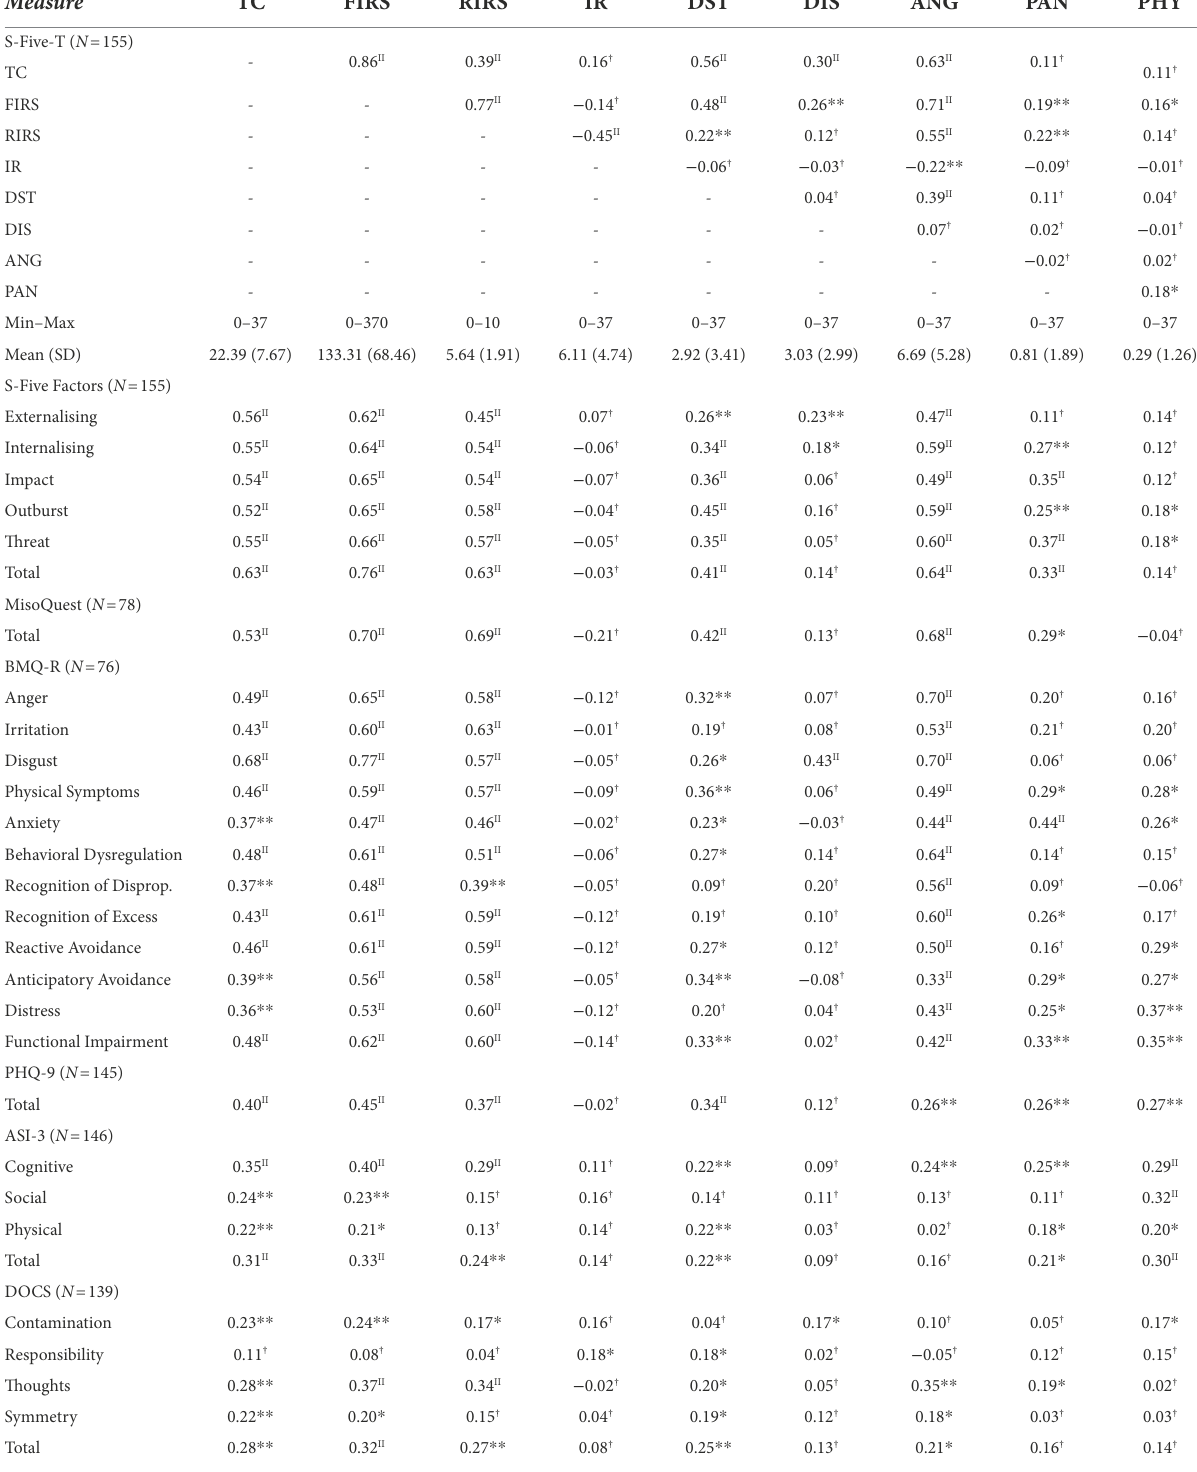
Table 6 Means, standard deviations and intercorrelations of the S-Five-T scores, S-Five, the BMQ-R symptom part, MisoQuest, PHQ-9, DOCS, and ASI-3. Measure TC